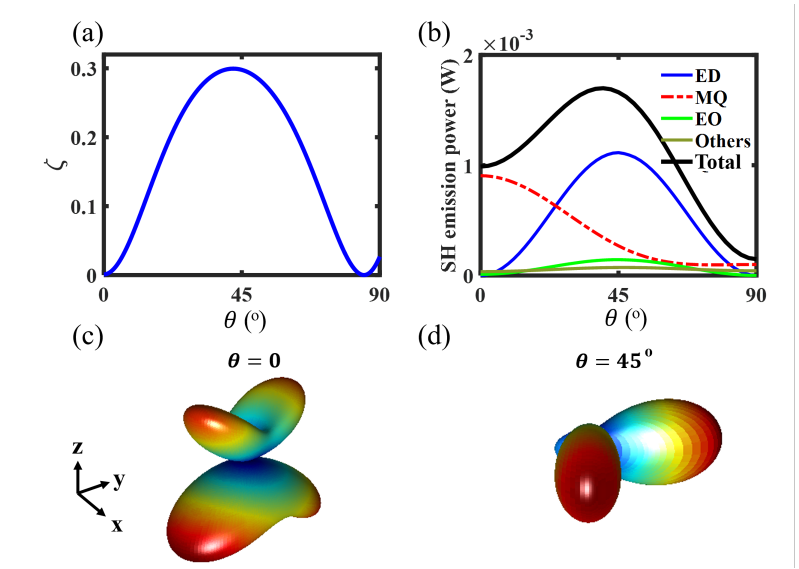
Figure 4. ( a ) Calculated overlap ζ for different pump tilt angle; ( b ) the multipolar structure of SH emission with different pump tilt angle. ( c , d ) gives the far-field patterns for pump tilt angle θ = 0 ◦ and 45 ◦ , respectively.